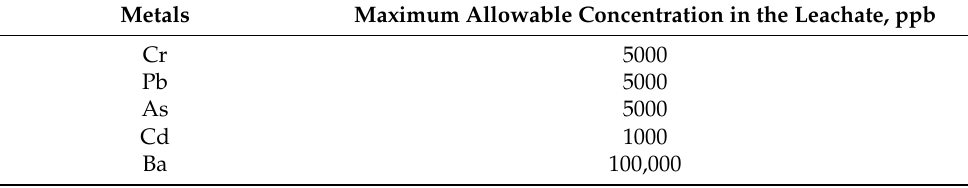
Table 8. Maximum concentrations of metals or toxic elements in the leachate according to the TCLP method [1].